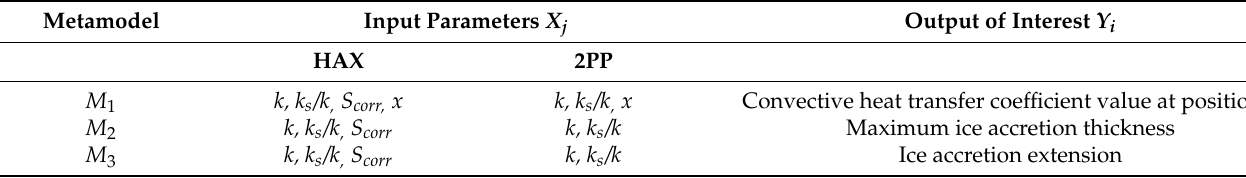
Table 2. Metamodels generated.